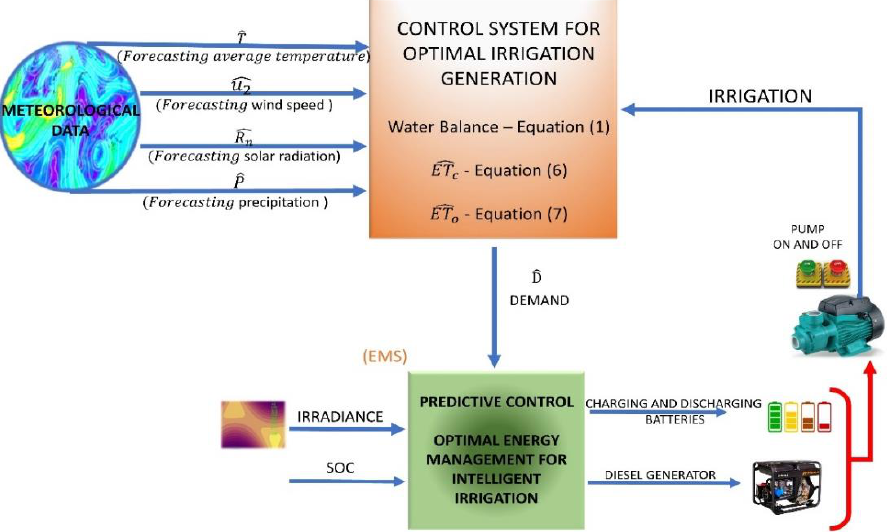
Figure 3. Proposal for a smart irrigation system, considering optimal EMS.